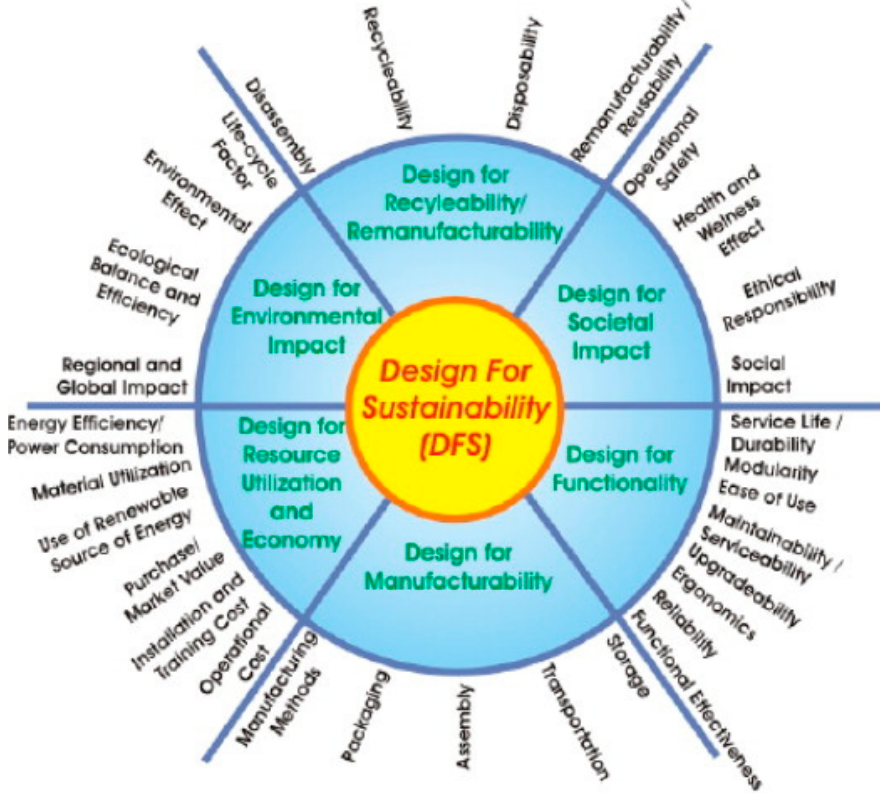
Figure 3. Elements within design for sustainability (DfS) [89].